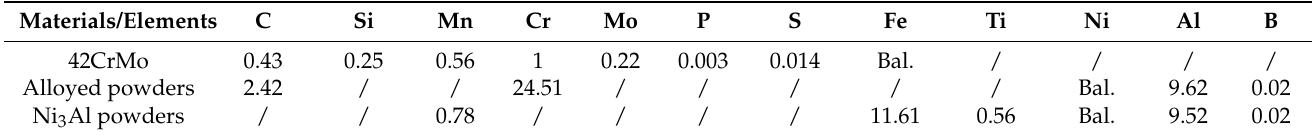
Table 1. 42CrMo alloy steel and powders chemical composition (wt.%).